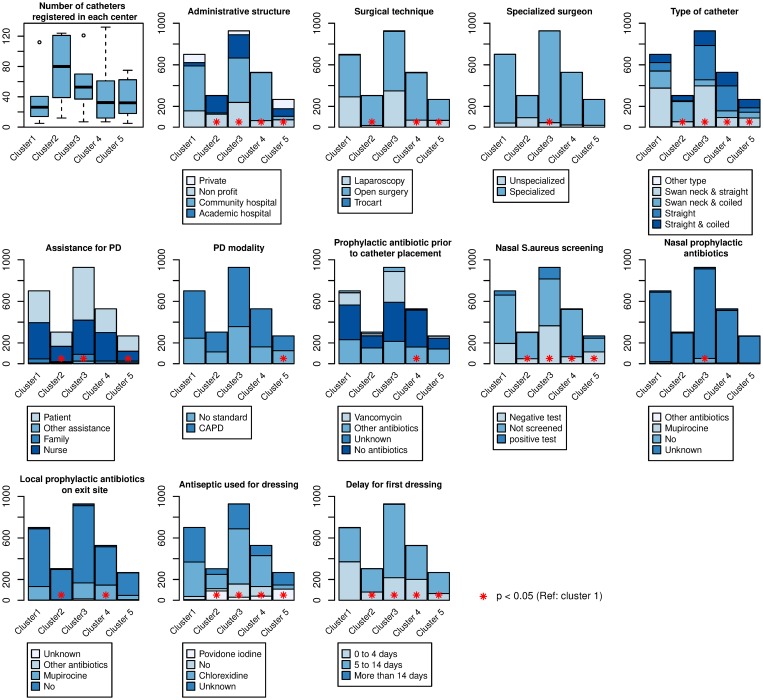
Distribution of practices in the five clusters of centers.The distribution of the modalities used for each practices is represented in the five clusters of centers. Statistically significant differences in the distribution of modalities with cluster 1 (taken as the reference) are marked with a red star.